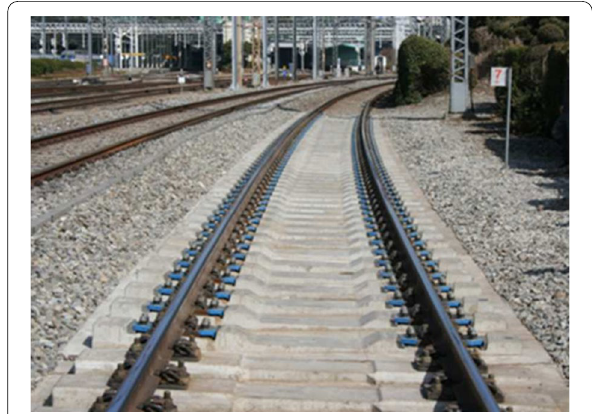
Fig. 1 Urban rail with PAC (Seoul metro) (Takahashi et al.,